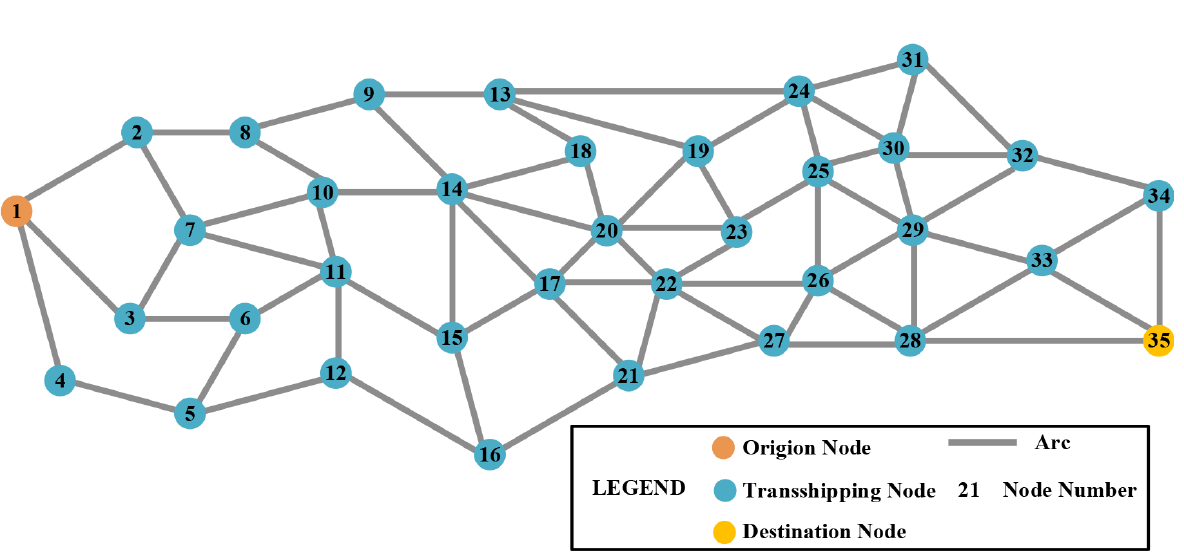
Figure 4. Topological structure of the 35-node multi-modal transportation